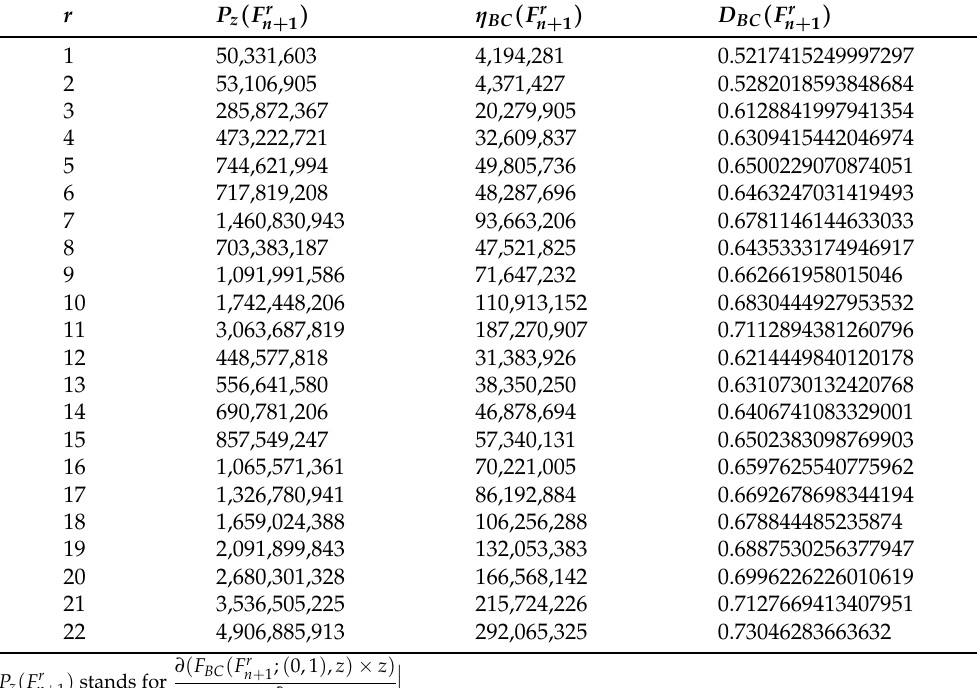
( 1 22 ) . r 22 + 1 ≤ ≤ , with n = 22 and r = 1,2, . . . n + 1